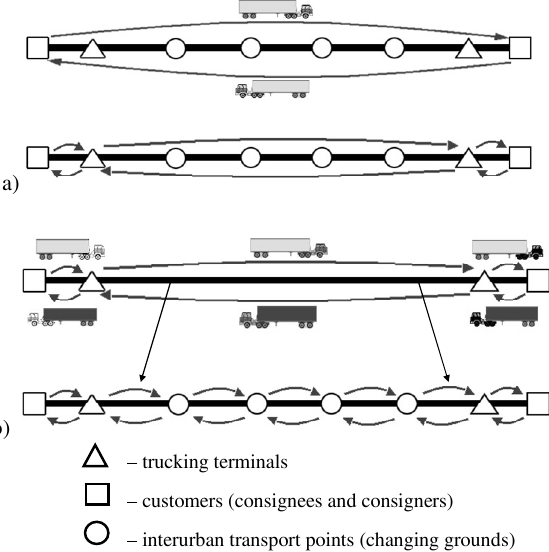
Fig 1. Interurban long haul service with use of road trains: